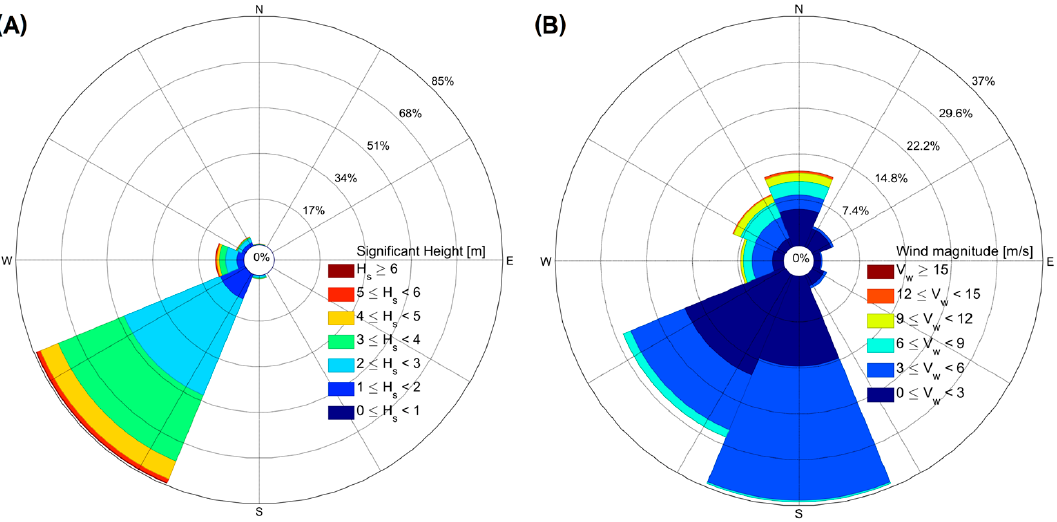
Figure 1. Wave and wind rose for: ( A ) WaveWatchIII (37° S 74° W node), and ( B ) the Arauco Gulf.